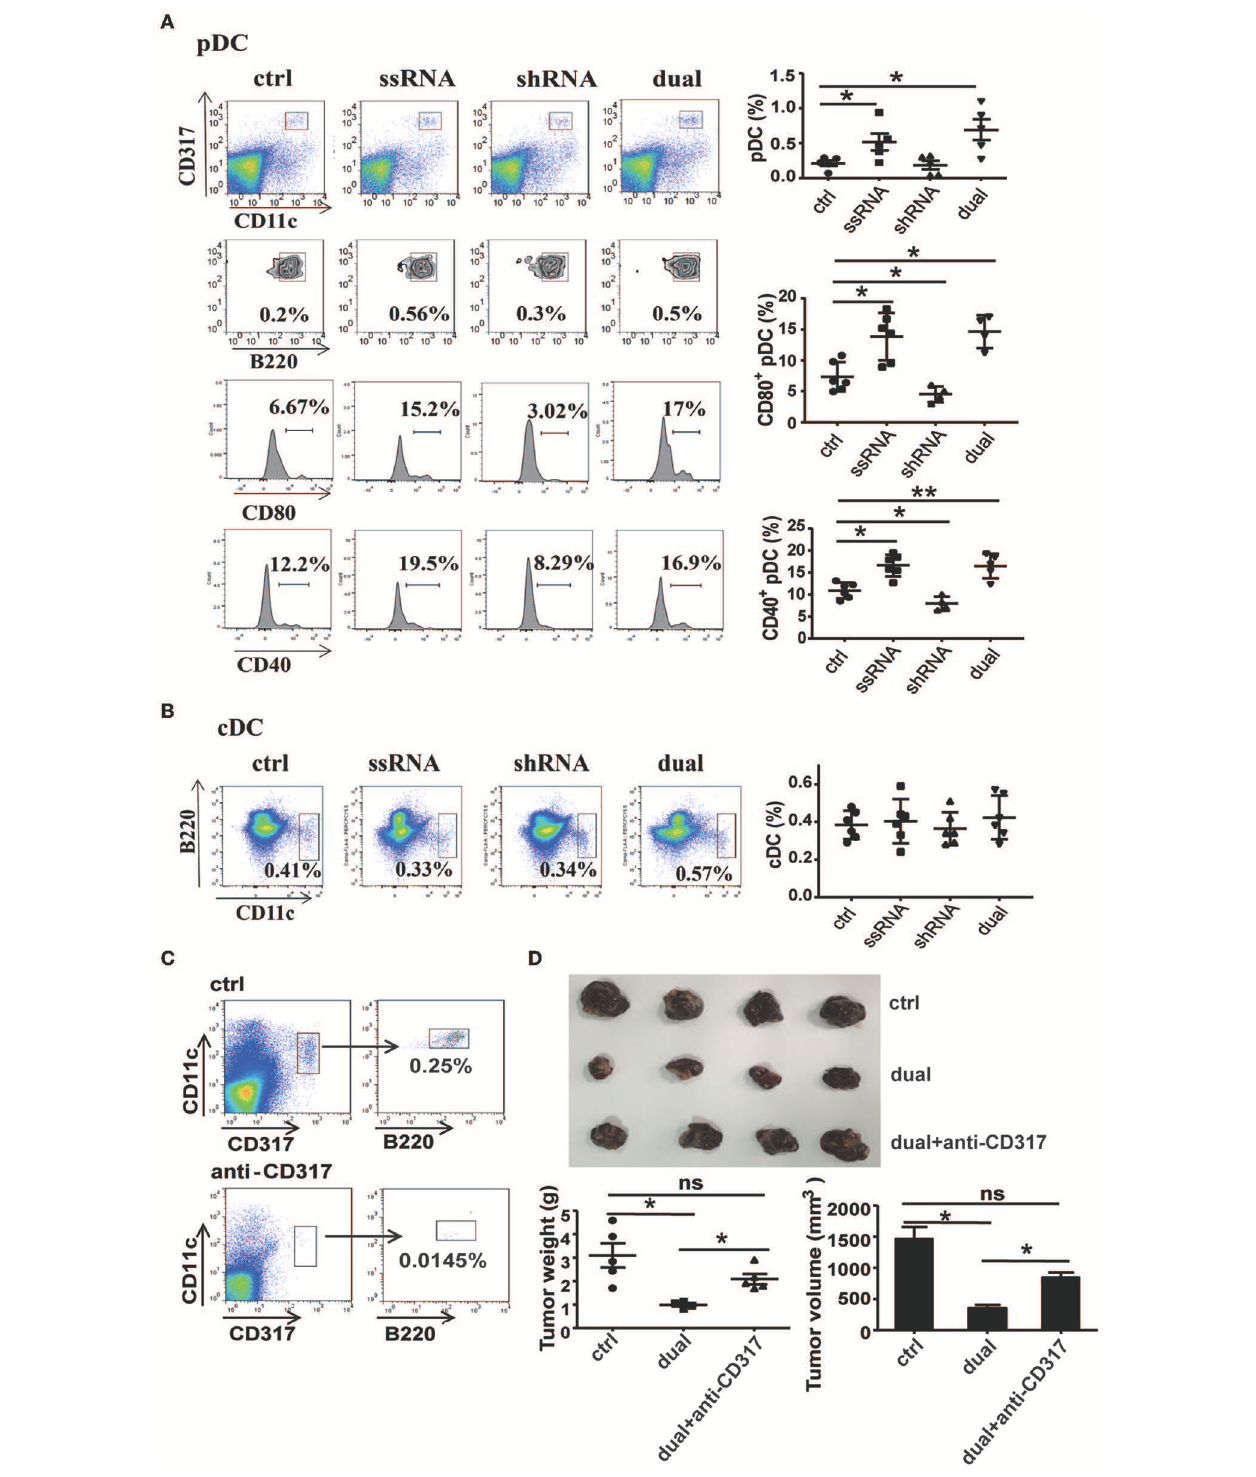
FIGURE 5 | pDCs are necessary for the treatment effect of the dual-function vector on B16F10 melanoma. (A) The percentages and activation of pDCs in tumor tissues of C57BL/6 mice were determined via flow cytometric analysis. (B) The percentages of cDCs in tumor tissues of C57BL/6 mice were determined via flow cytometric analysis. (C) pDC depletion effect of anti-CD317 antibody. (D) Image shows tumor sizes. And the tumor weight and volume were analyzed. Data are representative of three independent experiments. ** P < 0.01 or * P < 0.05 vs. control group. pDCs, plasmacytoid dendritic cells.